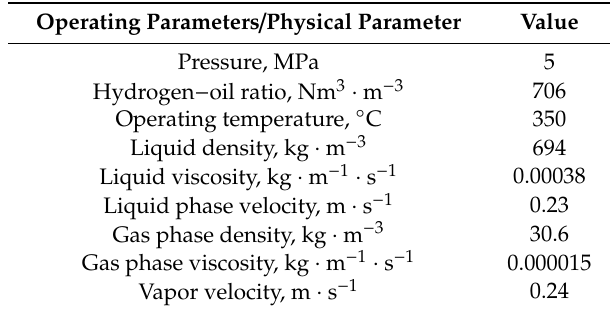
Table 2. Properties of oil materials and operating parameters